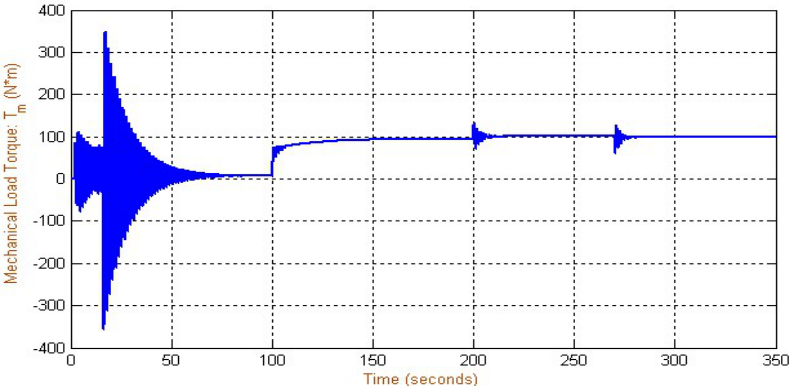
Figure 20. Mechanical load torque versus time.